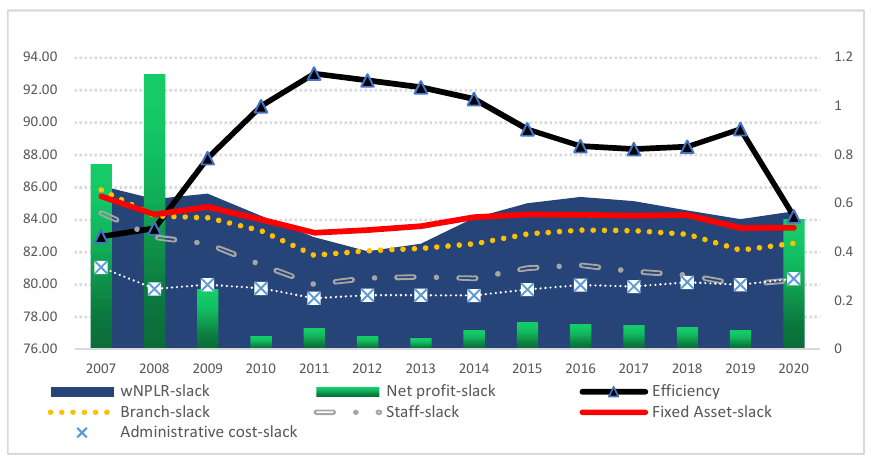
Figure 4. Average operating efficiency and slack variables.